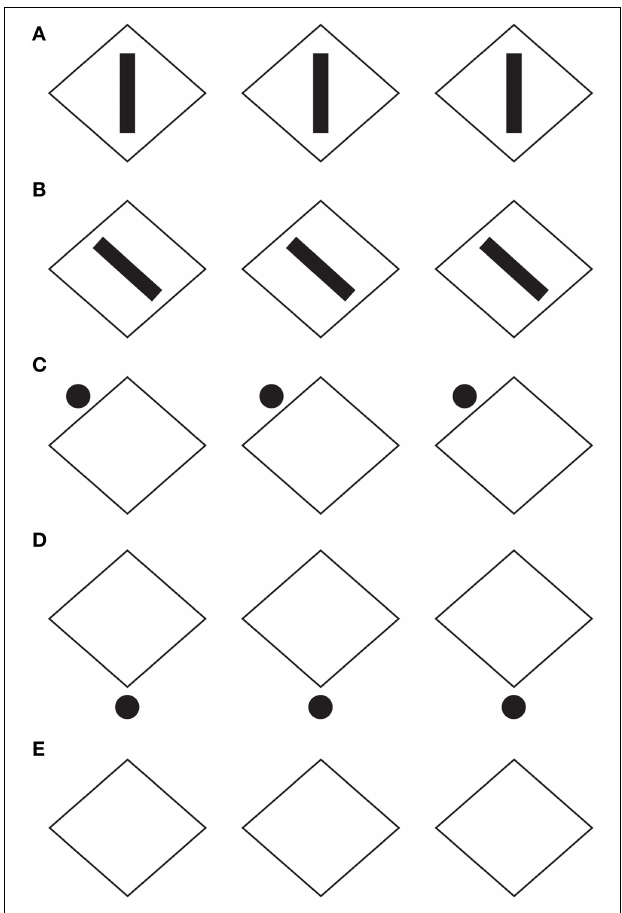
FIGURE 5 | The directional organization due to the filled elements induces diamonds and rotated squares as in Figure 4, although each shape is clearly perceived as a rhombus. For further details please see the text.